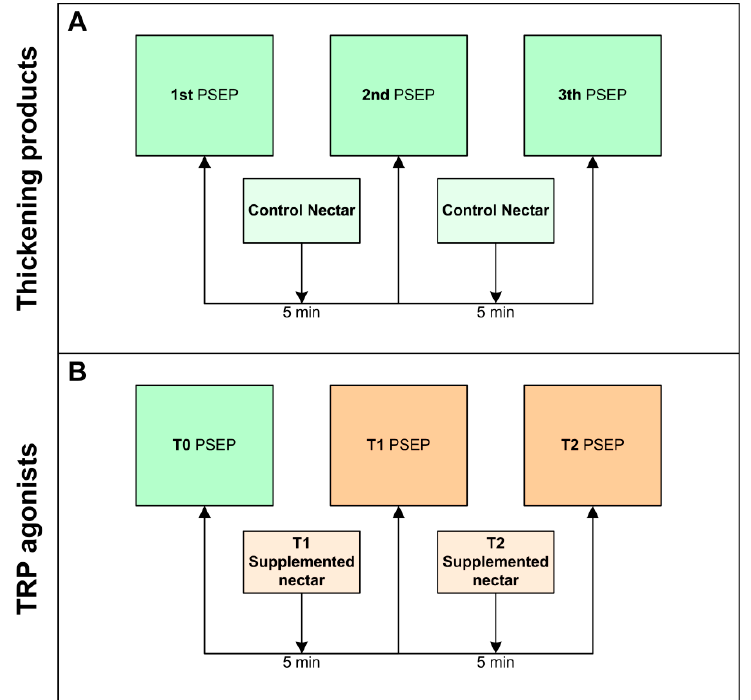
Figure 9. Pharyngeal sensory evoked potential (pSEP) algorithm for each type of treatment: ( A ) thickening products and ( B ) TRP agonists.